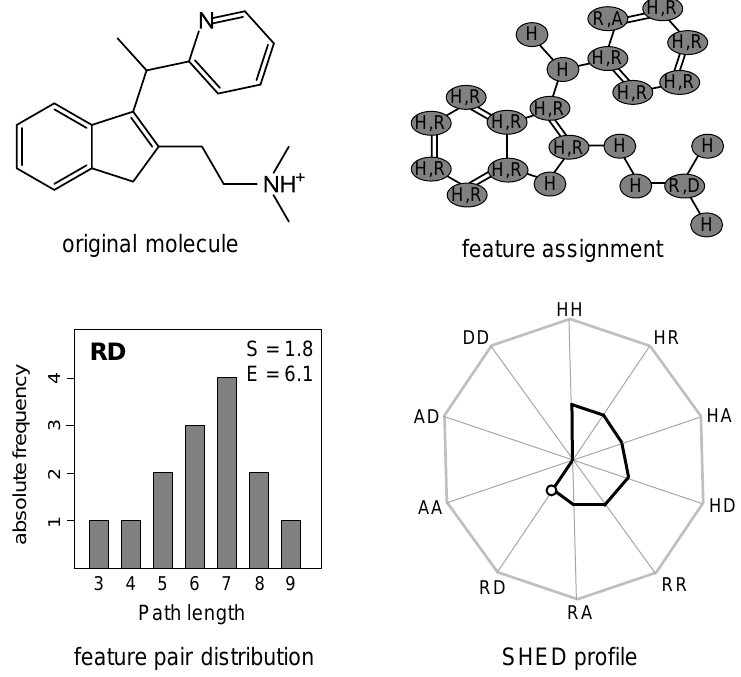
Figure 3. Calculation of SHED descriptors. Each atom in a molecule is assigned one or more of the following atomic features: hydrophobic (H), aromatic (R), hydrogen bond acceptor (A), or hydrogen bond donor (D). The pairwise combination of these features results into 10 possible feature pairs. For each pair, the distribution of topological distances between atoms with the respective features is determined. Here, the distribution is shown for the aromatic-donor feature (RD) pair. As can be seen, there is only one donor atom in the molecule. To obtain the RD distribution, the shortest path lengths (number of bonds) of the donor atom to 14 aromatic atoms present in the molecule are calculated. From this distribution, the Shannon entropy for the feature pair is derived and further transformed into a projected Shannon entropy value, i.e. E-value. The projected entropies of the 10 feature pair distributions are graphically displayed in a wheel chart. The small circle in the chart indicates the E-value for the RD feature